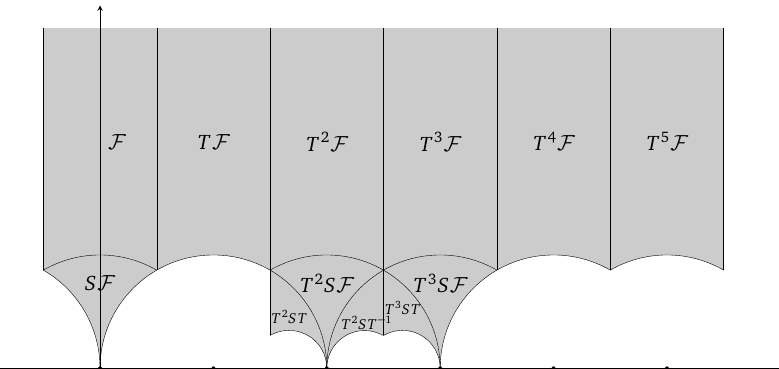
Figure 19: Fundamental domain for Γ 0 ( 6 ) with cusps at τ = 0,2,3 and i ∞ of widths 1,3,2 and 6,